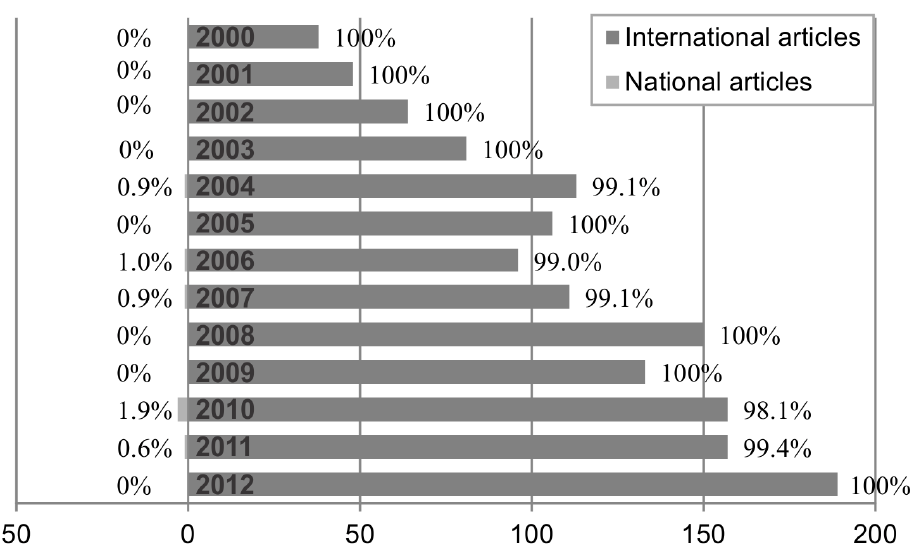
Figure 1. National versus international articles in Brazilian scientific output in Evolutionary Biology.